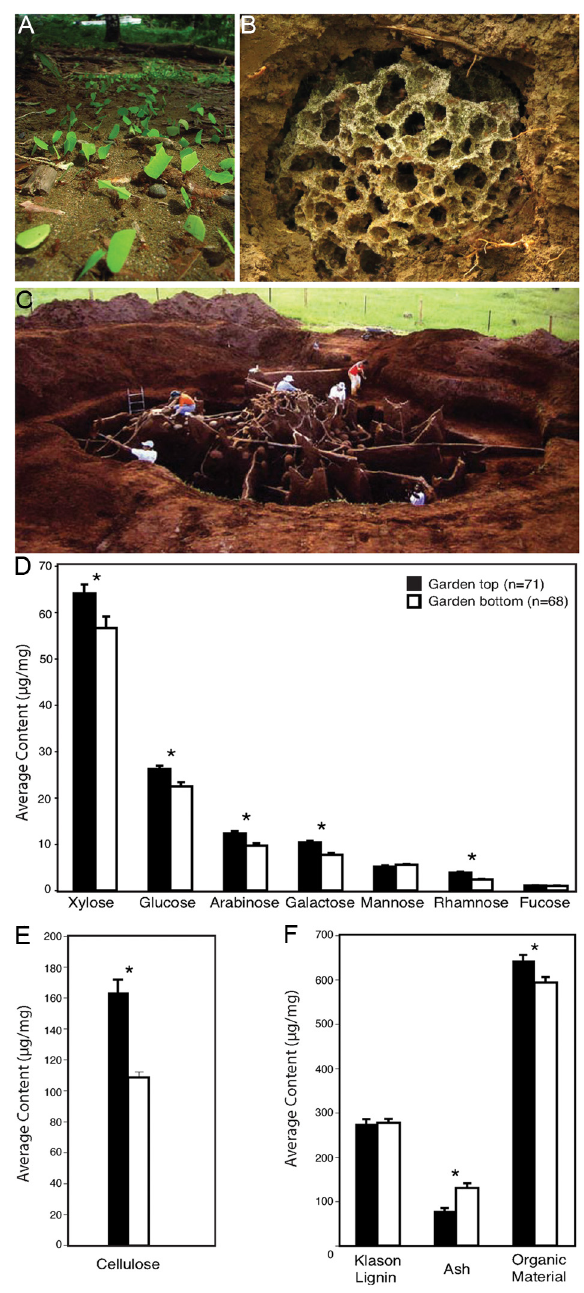
Figure 1. Organic polymer characterization of leaf-cutter ant fungus gardens. Leaf-cutter ants forage for leaves (A) that they use to cultivate a fungus in specialized gardens (B) within their massive colonies (C). Sugar composition analysis of the plant biomass from the top and bottom layers of multiple fungus garden chambers shows an overall decrease in average content for many of the components of hemicellulose (D) and cellulose (E). In contrast, lignin (F) exhibited no change in average content. Error bars in graphs are standard error of the mean. The asterisks indicate a significant decrease in overall average content between top and bottom samples (two-tailed paired t test, P , 0.05). [Photo credits: river of leaves, used under the GNU Free Documentation License CC-BY-SA-3.0,2.5,2.0,1.0; exposed fungus gar- den, Jarrod J. Scott/University of Wisconsin-Madison; concrete nest, Wolfang